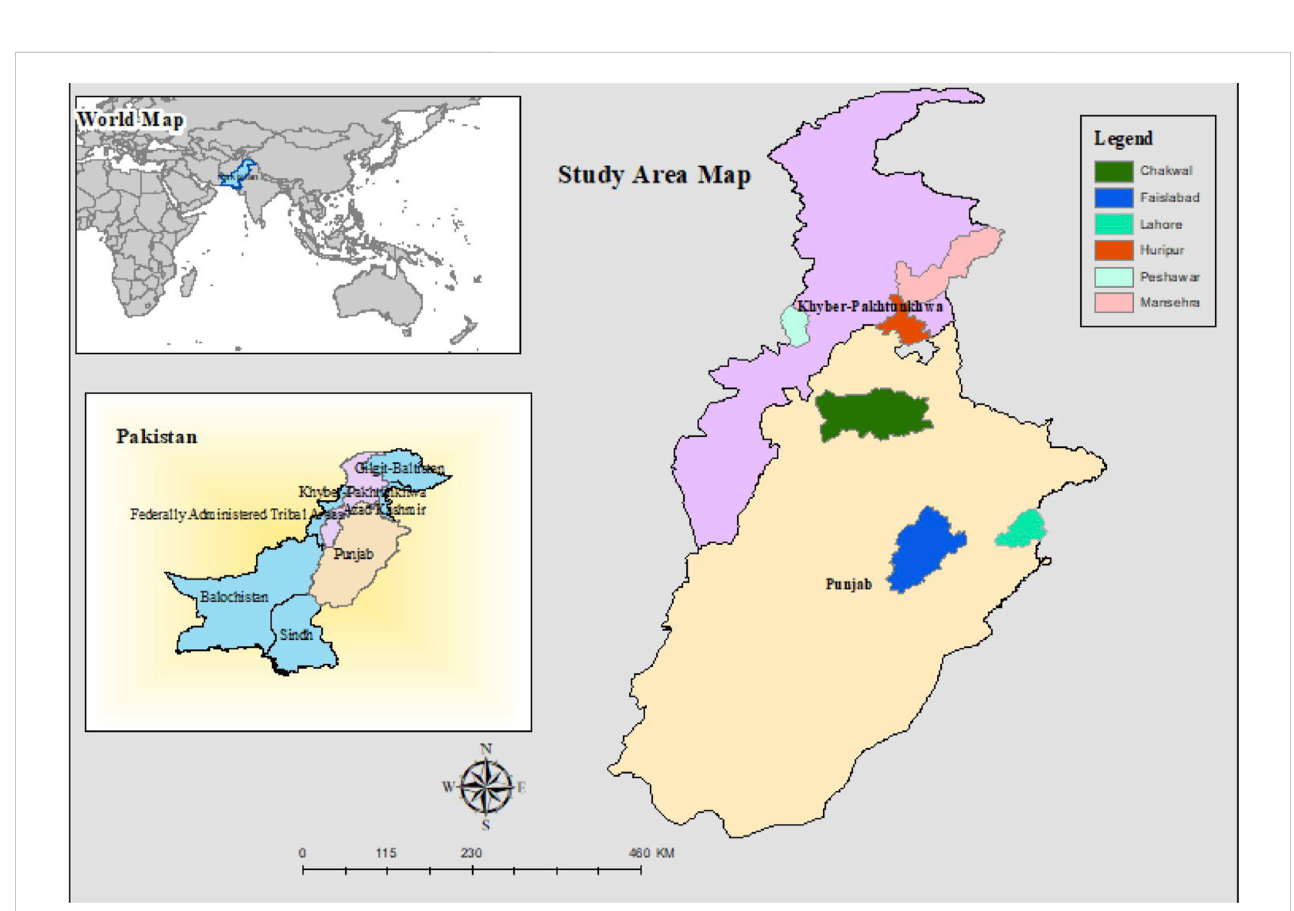
FIGURE 2 Map of the study area (ArcGIS